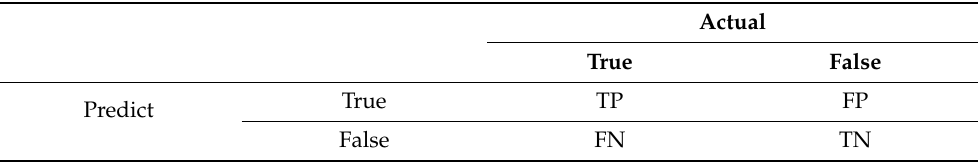
Table 1. True positive (TP), false positive (FP), false negative (FN), and true negative (TN) are defined based on the confusion matrix.